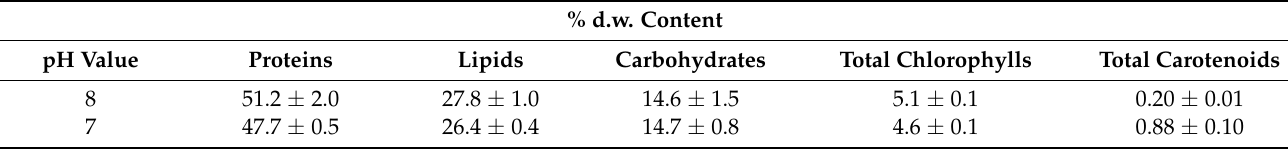
Table 6. Effect of pH on biomass biochemical composition. % d.w.